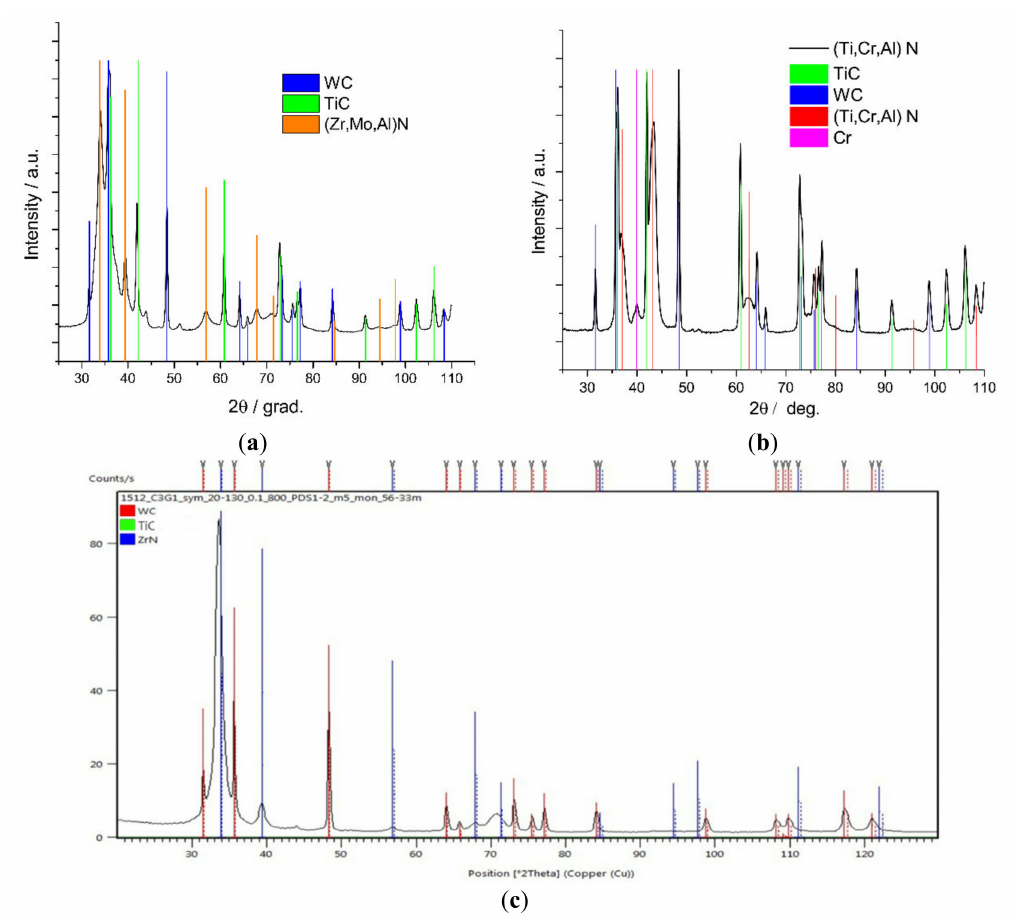
Figure 2. Investigation of the phase composition of the coatings, conducted by the X-ray diffraction (XRD) technique: ( a ) Zr-ZrN-(Zr,Mo,Al)N, ( b ) Ti-TiN-(Ti,Cr,Al)N, and ( c ) ZrN. The WC and TiC phases of the carbide substrate are also